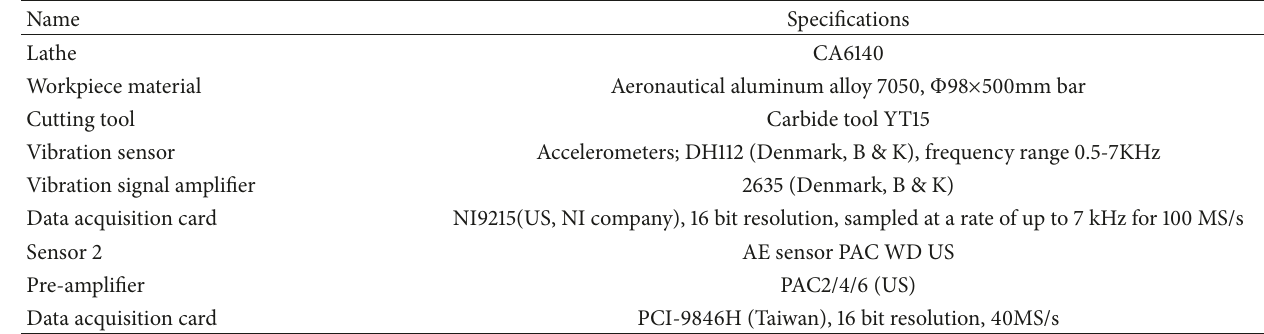
Figure 2: Structural frame of tool condition monitoring. Table 1: Experimental instrumentation and specifications.